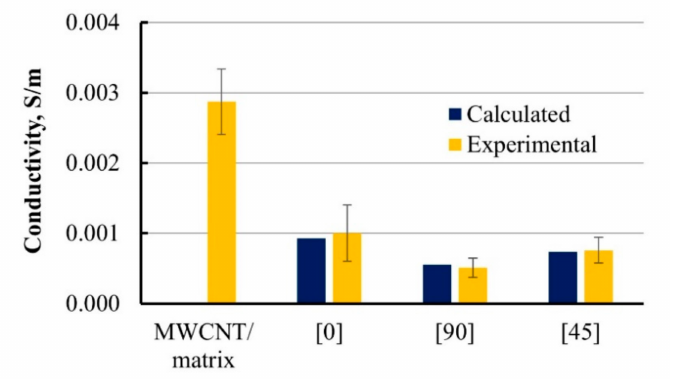
Figure 8. Calculated and experimental conductivity of UD GFRP with 0.3 wt.% MWCNT-modified epoxy matrix and its based composite bars with reinforcing angles 0 ◦ , 90 ◦ , and 45 ◦